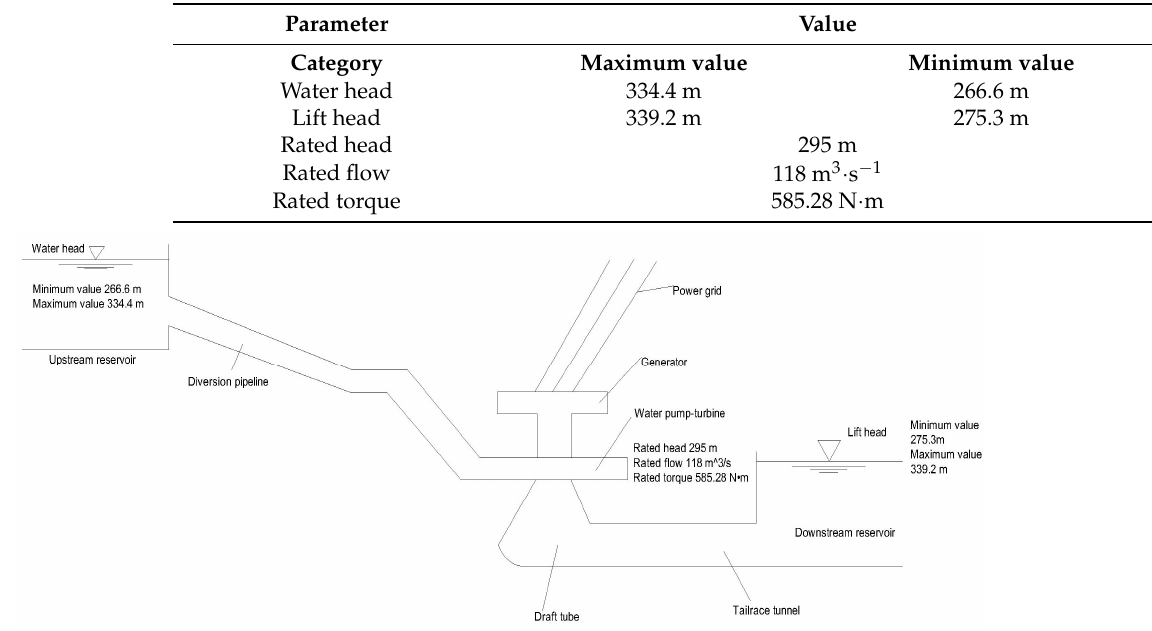
Table 1. Main parameters of water pump-turbine.